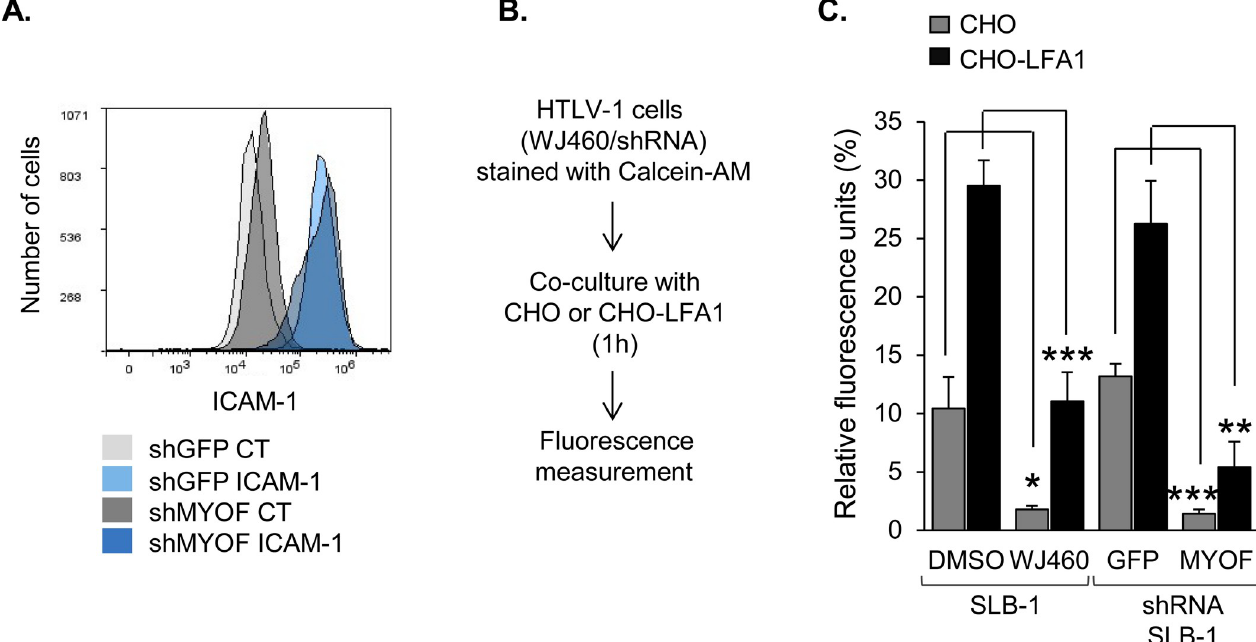
Fig 8. MyoF enhances HTLV-1-infected T-cell adhesion without affecting cell surface abundance of ICAM-1. (A) Knockdown of MyoF expression does not affect the level of ICAM-1 at the cell-surface. SLB-1 cells stably expressing an shRNA targeting GFP (negative control) or MYOF mRNA were labeled with an antibody against ICAM-1 followed by a FITC-conjugated secondary antibody, fixed and analyzed by flow cytometry. Histograms show relative cell surface labeling as follows: secondary antibody alone- (CT) and ICAM-1-labeled shGFP cells, light gray and light blue, respectively; secondary antibody alone- (CT) and ICAM-1-labeled shMYOF cells, dark gray and dark blue, respectively. (B) Knockdown or inhibition of MyoF reduces adhesion to CHO cells independent of LFA-1 expression. The flow diagram shows the co-culture/adhesion assay procedure using CHO or CHO-LFA-1 adherent cells. (C) Adhesion assays of HTLV-1 infected cells stably expressing shGFP or shMyoF to adherent cells. The graph shows binding of SLB-1 cells pretreated with DMSO or 1 μ M WJ460, or SLB-1 cells stably expressing an shRNA targeting GFP (negative control) or MYOF mRNA, to CHO (grey) or CHO-LFA1 (black) cells. Values are the average of three replicates from one experiment and representative of three independent experiments; � p < 0.05, �� p < 0.01, ��� p < 0.001.